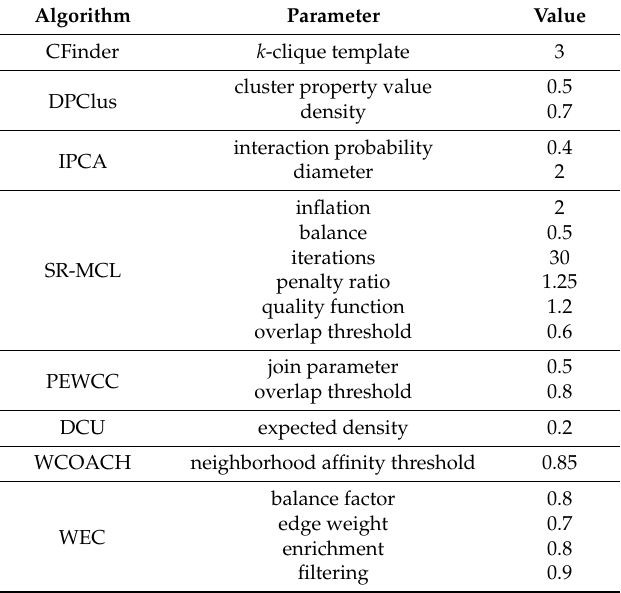
Table 4. Parameters of each